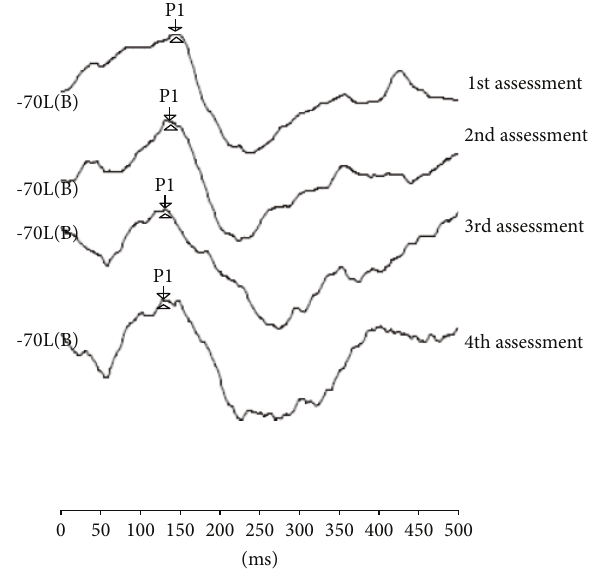
Figure 2: Analysis of LLAEP traces at four assessments of the hearing